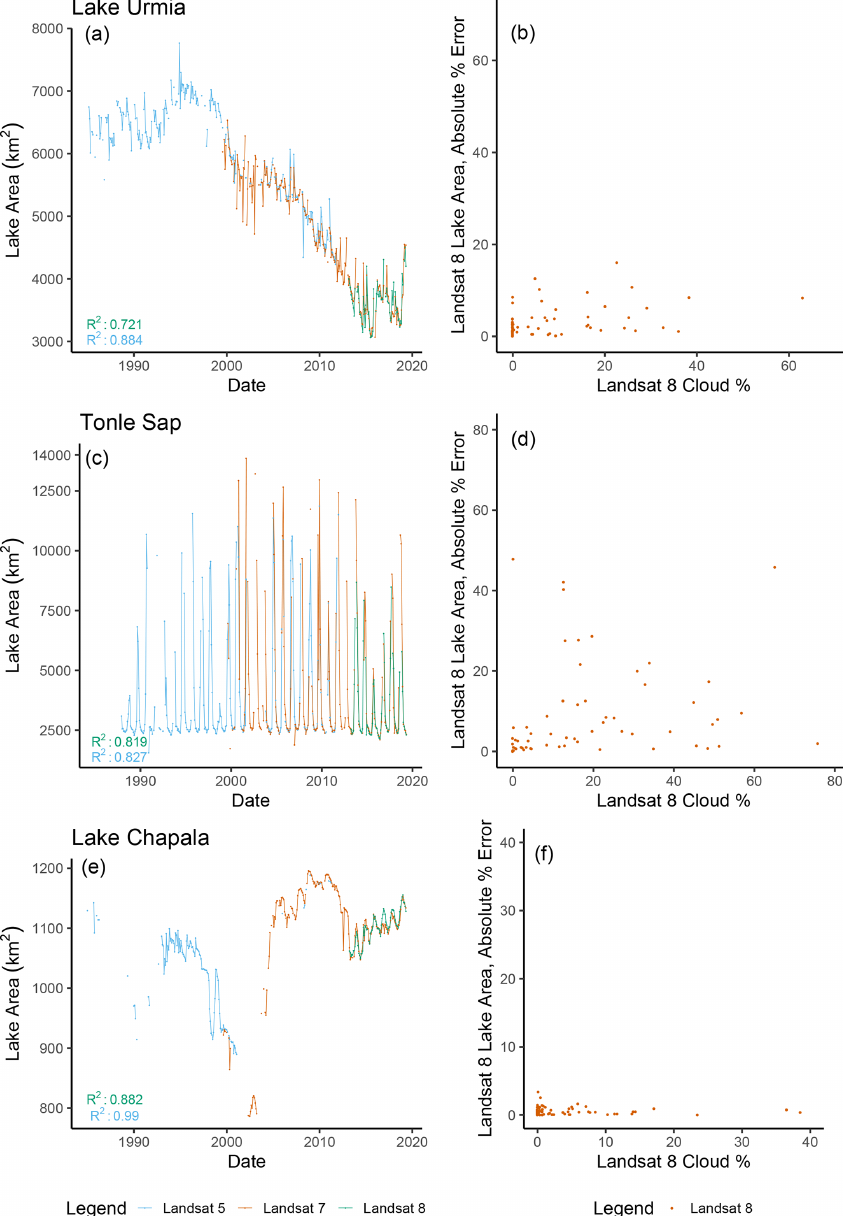
Figure 5. Implementation of the approach on lakes with documented changes. (a, c, e) Time series of monthly lake extent estimates from Landsat 5 (blue), Landsat 7 (brown), and Landsat 8 (green) for lakes Urmia (a) , Tonlé Sap (c) , and Chapala (e) . (b, d, f) Scatterplot of absolute percentage errors on Landsat 8 water extent estimates (compared to Landsat 7 estimates) against the proportion of the lake’s maximum footprint that is covered by